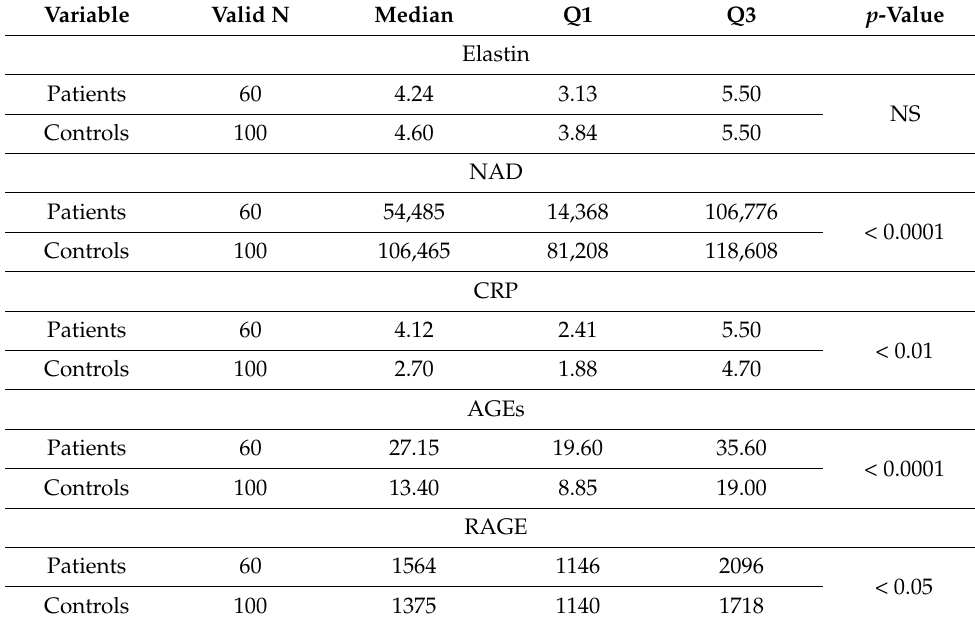
Table 2. Laboratory findings expressed as medians and interquartile ranges (Q1,Q3).